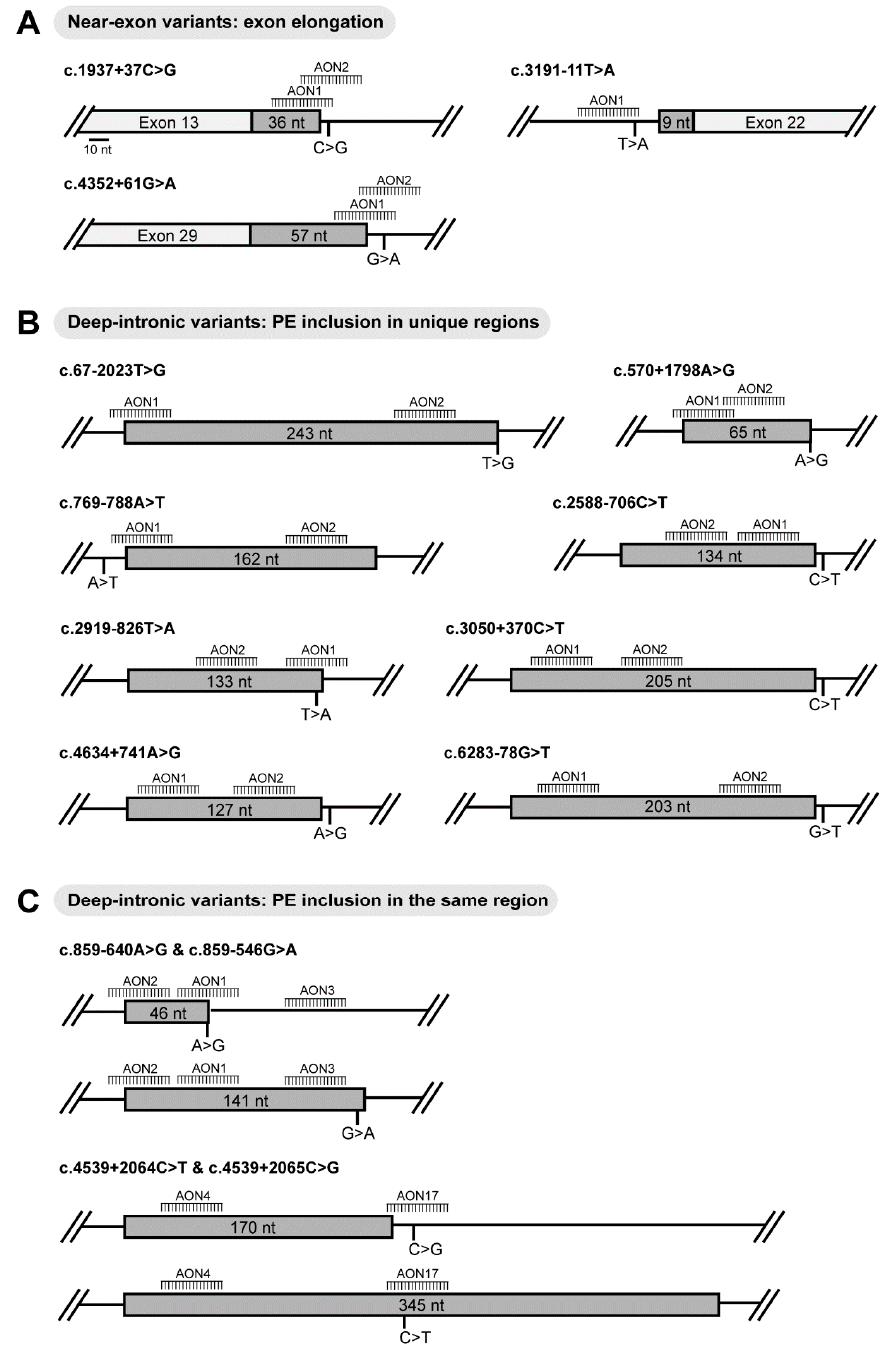
Figure 1 . Schematic representation of the different splicing alterations caused by 15 intronic ABCA4 variants and the respective position of the designed 26 antisense oligonucleotides (AONs) in this study. ( A ) Position of the AONs targeting exon elongation caused by the indicated near-exon variants. ( B ) Position of the AONs targeting the corresponding pseudoexon (PE) inclusion caused by the indicated deep-intronic variants in unique regions. ( C ) Position of the AONs targeting the corresponding pseudoexon (PE) inclusion caused by the indicated deep-intronic variants in the same region.